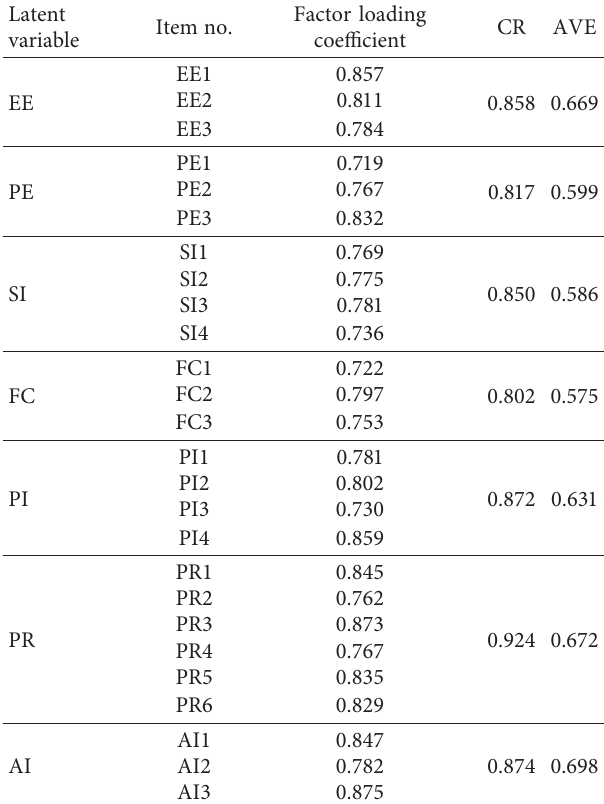
Table 4: Analysis results of reliability and convergent validity.